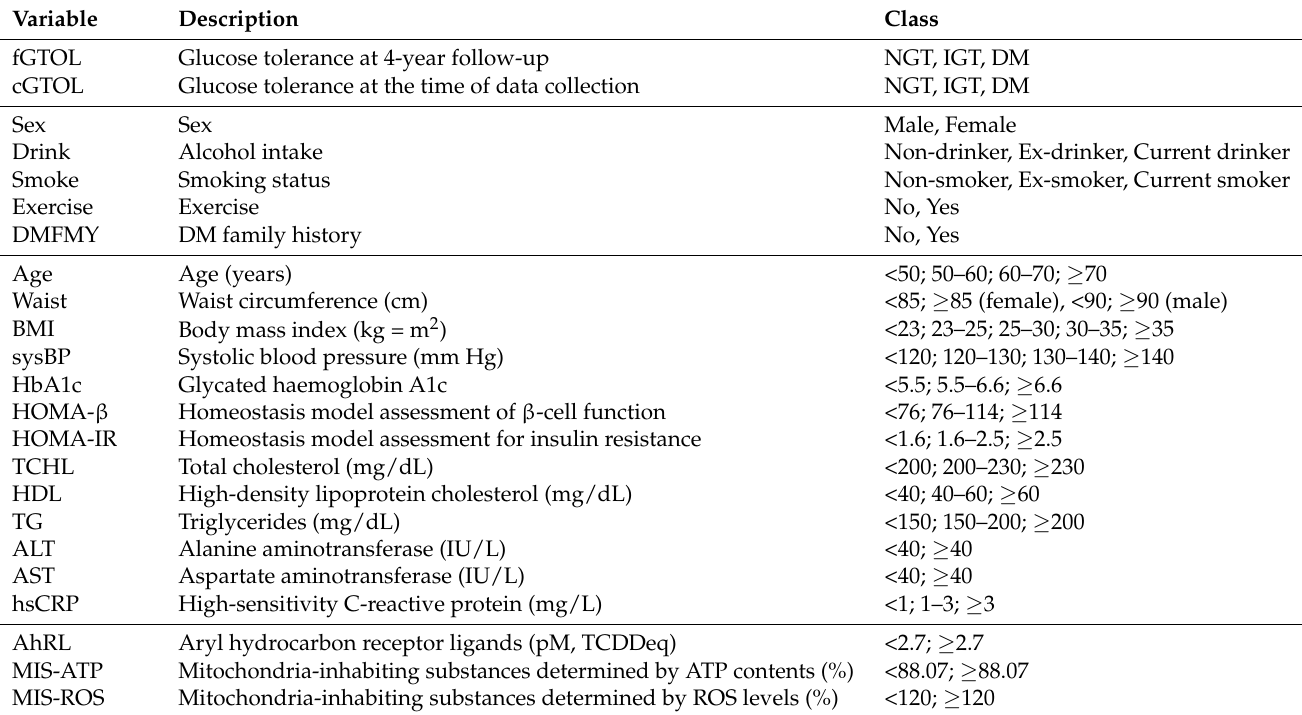
Table 1. Description and discretization of